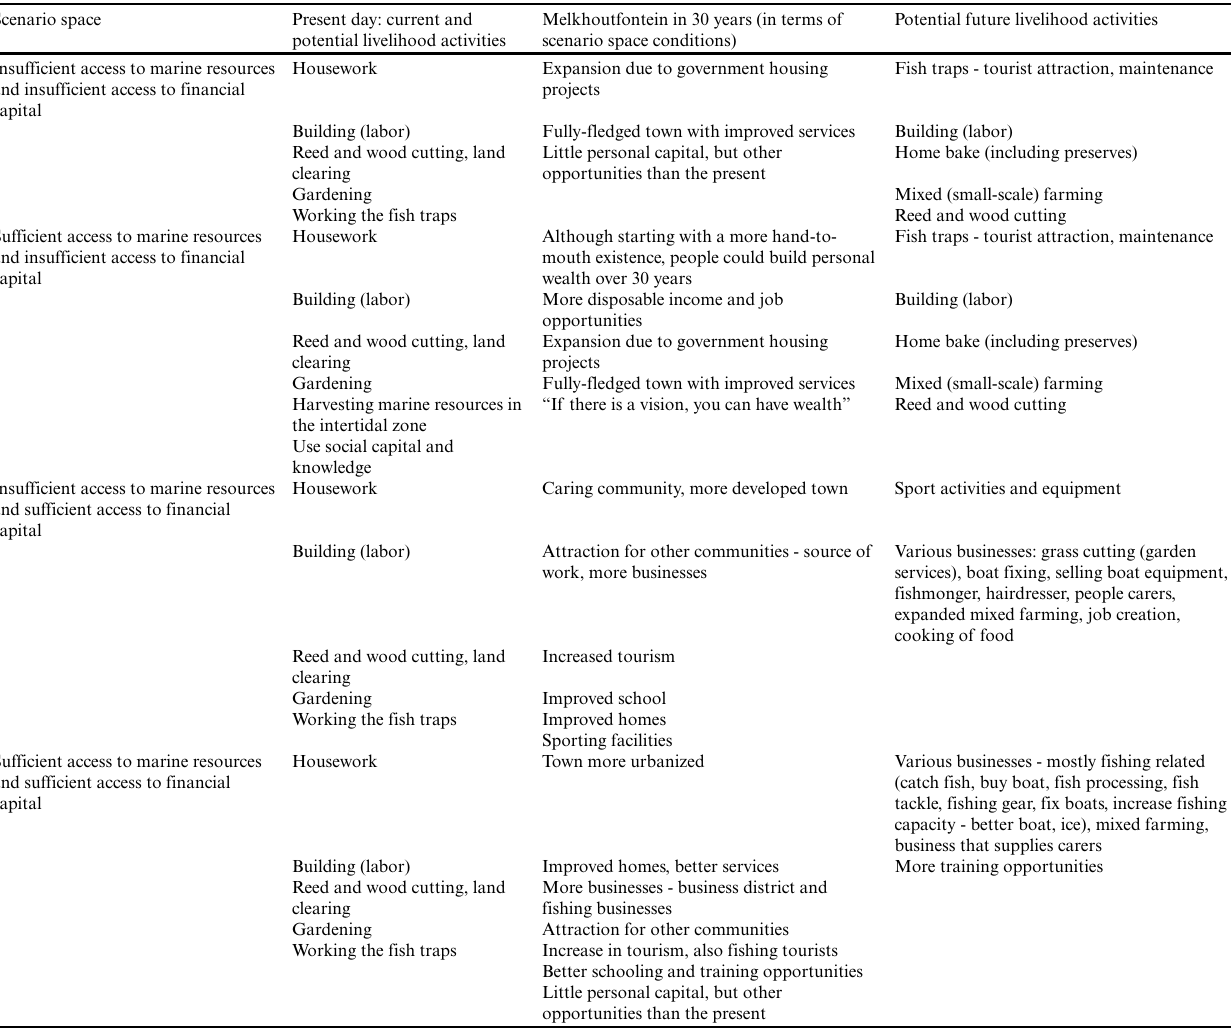
Table 1 . Key elements of each participant-derived scenario